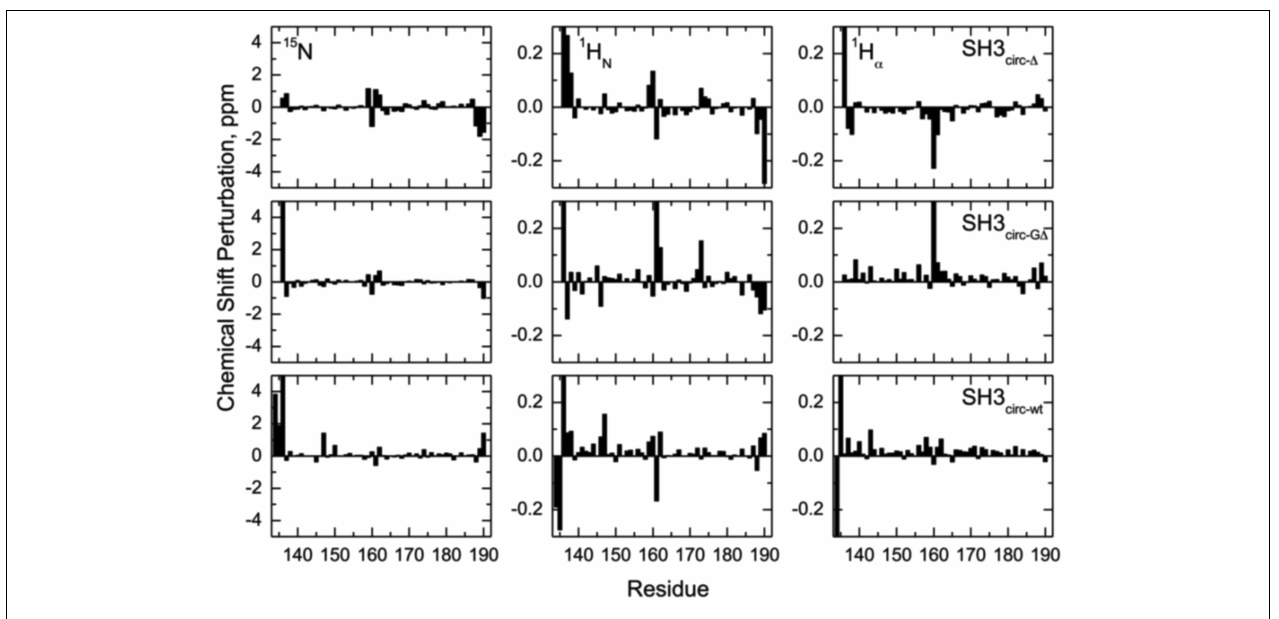
1 H 1 H α , respectively. The rows, from top to bottom, N , and correspond to SH3 circ - 1 , SH3 circ - G 1 , and SH3 circ - wt . In the case of Gly, shown is the largest of the chemical shift perturbations for the two α